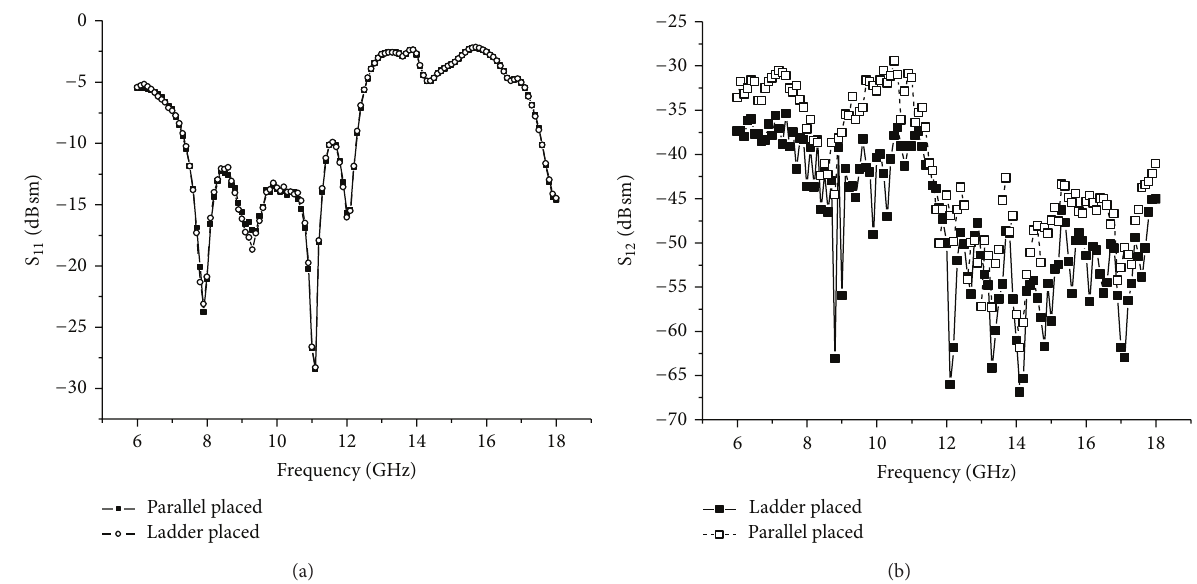
Figure 5: (a) Measured S 11 of two-element array. (b) Measured S 12 of two-element array.